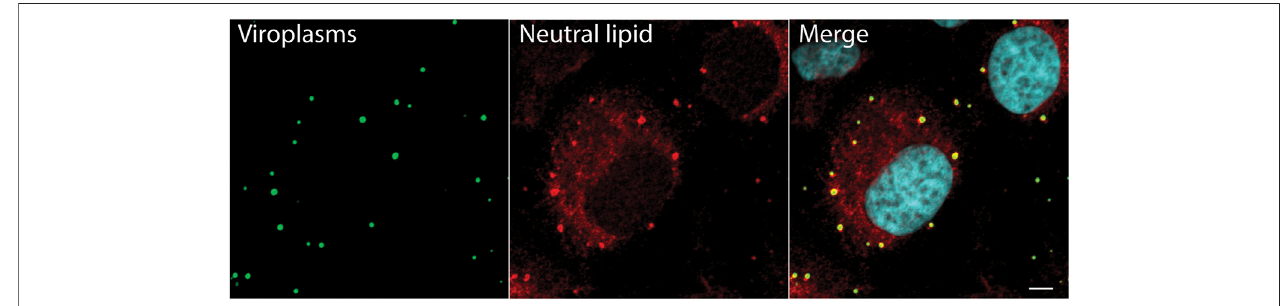
FIGURE1| Neutrallipidcontaininglipiddropletscolocalizewithviroplasms.Immuno fl uorescenceconfocalmicroscopywasusedtodetectviroplasms(anti-NSP2,